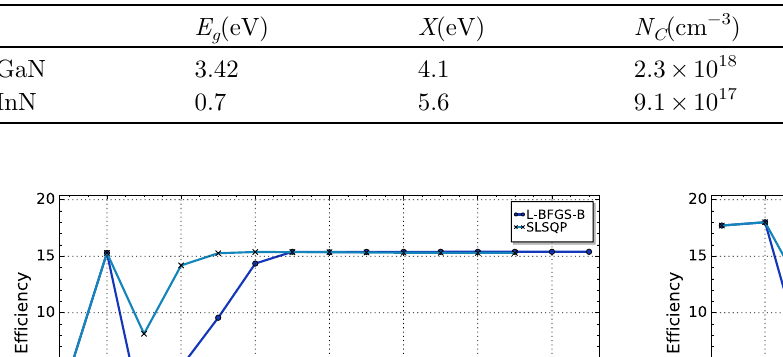
Table 1. Bandgap E , af fi nity X , permittivity e , and densities of states in the conduction band N g of GaN and InN [29 – 31]. The absorption is given by equation (2), the C and D values being fi tting from band N V the incident photons energy and E experimental data [32], with E ph